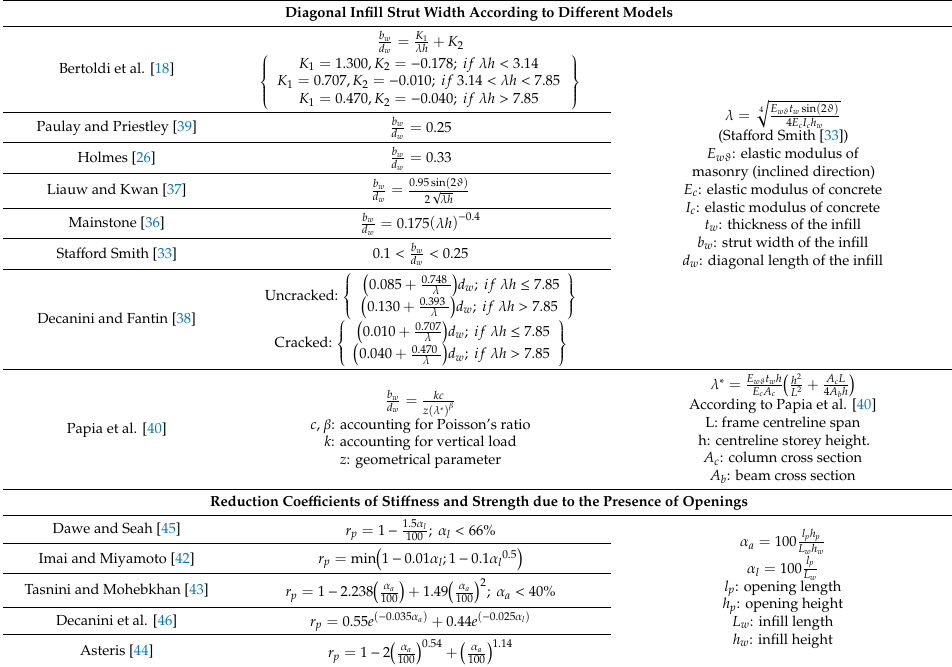
Table 1. Formulations to evaluate the width of the strut and reduction coe ffi cients of sti ff ness and strength due to the presence of the openings.